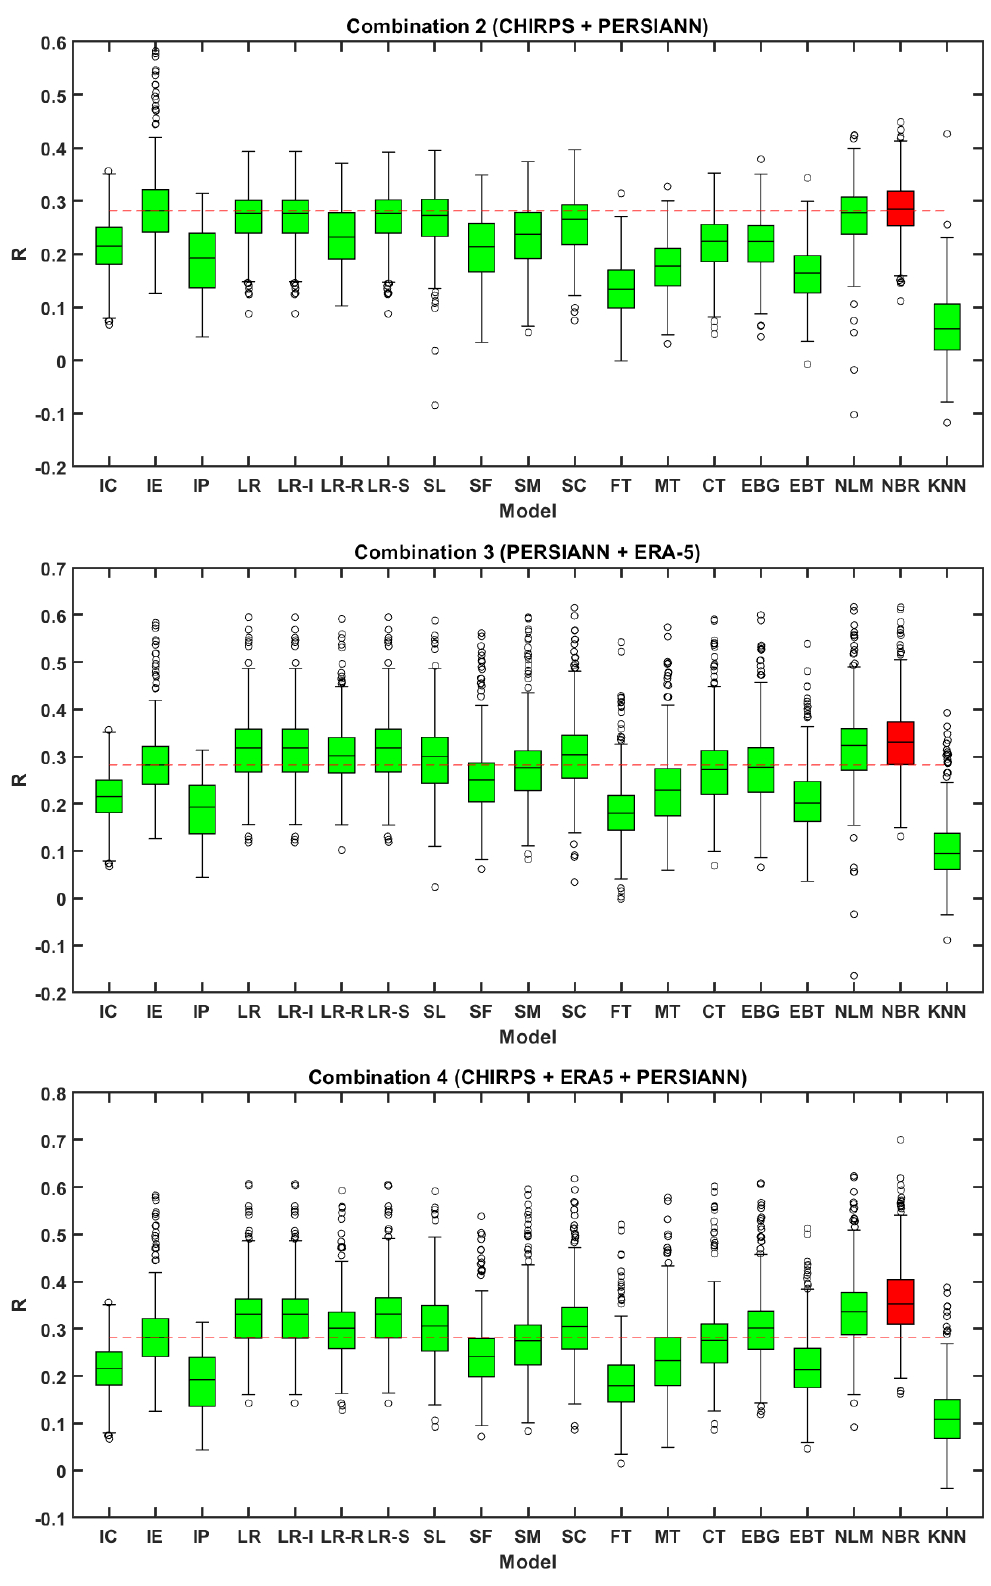
Figure 4. Boxplots representing the performance of individual and integrated precipitation dataset under four combinations in terms of R (IC represents IMD vs. CHIRPS, IE represents IMD vs. ERA-5, and IP represents IMD vs. PERSIANN